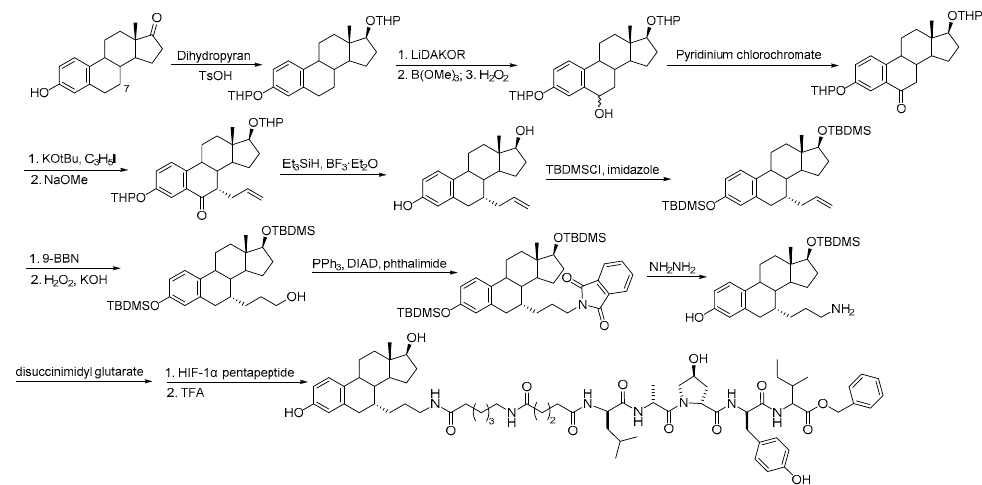
Scheme 1. Synthesis of C16-derivatized estradiol–based PROTAC.